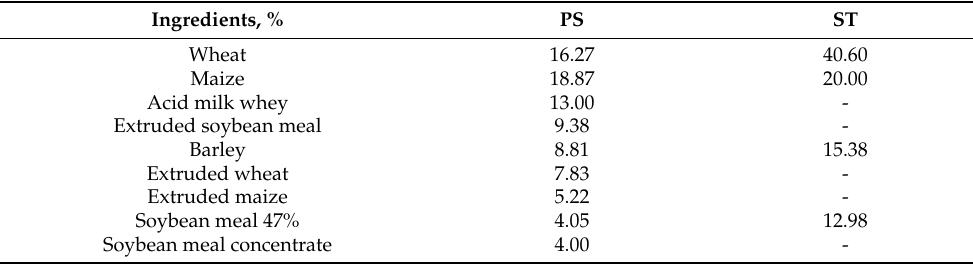
Table 1. Composition of the basal diet, as-fed basis, for prestarter (PS) and starter (ST) phases. Ingredients,